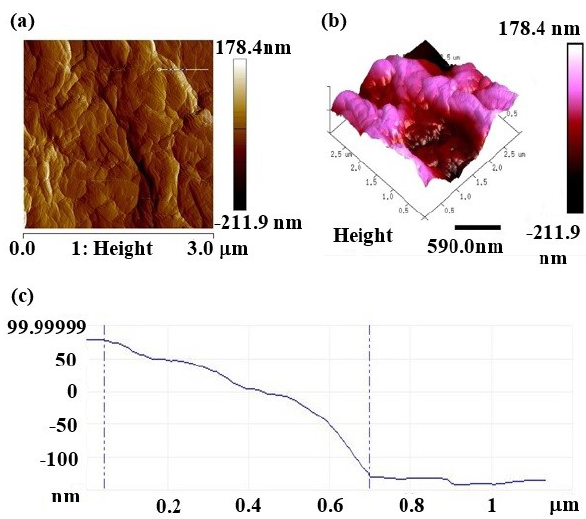
Figure 4. FESEM images of ( a ) GO; GO electrochemically reduced at ( b ) 5 V, ( c ) 10 V, ( d ) 15 V, ( e ) 20 V, and ( f ) 25 V.